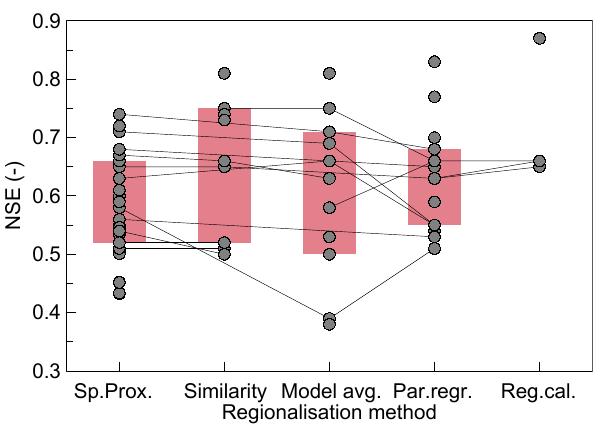
Reg.cal. Fig. 3. Median Nash–Sutcliffe efficiency of predicting hydrographs in ungauged basins stratified by regionalisation method (Level 1 as- Fig. 4. Median Nash–Sutcliffe efficiency of predicting hydrographs sessment). Each symbol refers to a result from the studies in Table 1. in ungauged basins stratified by the number of catchments within Lines indicate studies that compared different methods for the same each study (Level 1 assessment). Each symbol refers to a result from set of catchments. Boxes show 25–75% quantiles. the studies in Table 1. Boxes show 25–75%